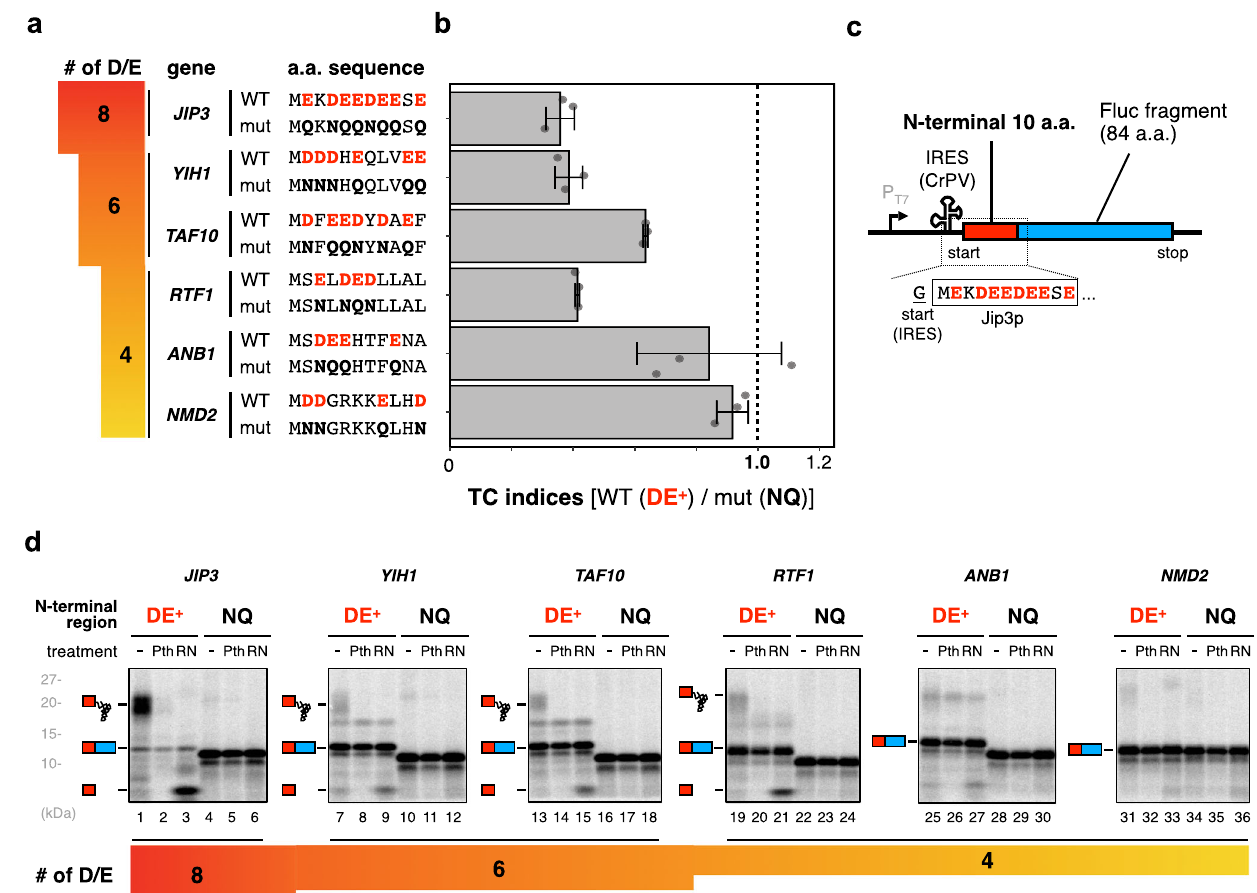
Fig. 3 | Translation of endogenous genes that have multiple Asp/Glu (D/E) residuesintheN-terminalregions.a Thelistofrepresentativegeneswith8,6,and 4 D/Es in the N-terminal 11 amino acids. The N-terminal sequences ( wt ) are shown with the mutant sequences ( mut ), in which D/Es are substituted by N/Qs. b The N-terminal 10 amino acid sequences except for the fi rst methionine were inserted instead of the 10X in the dual-luciferase reporter construct shown in Fig. 1a.